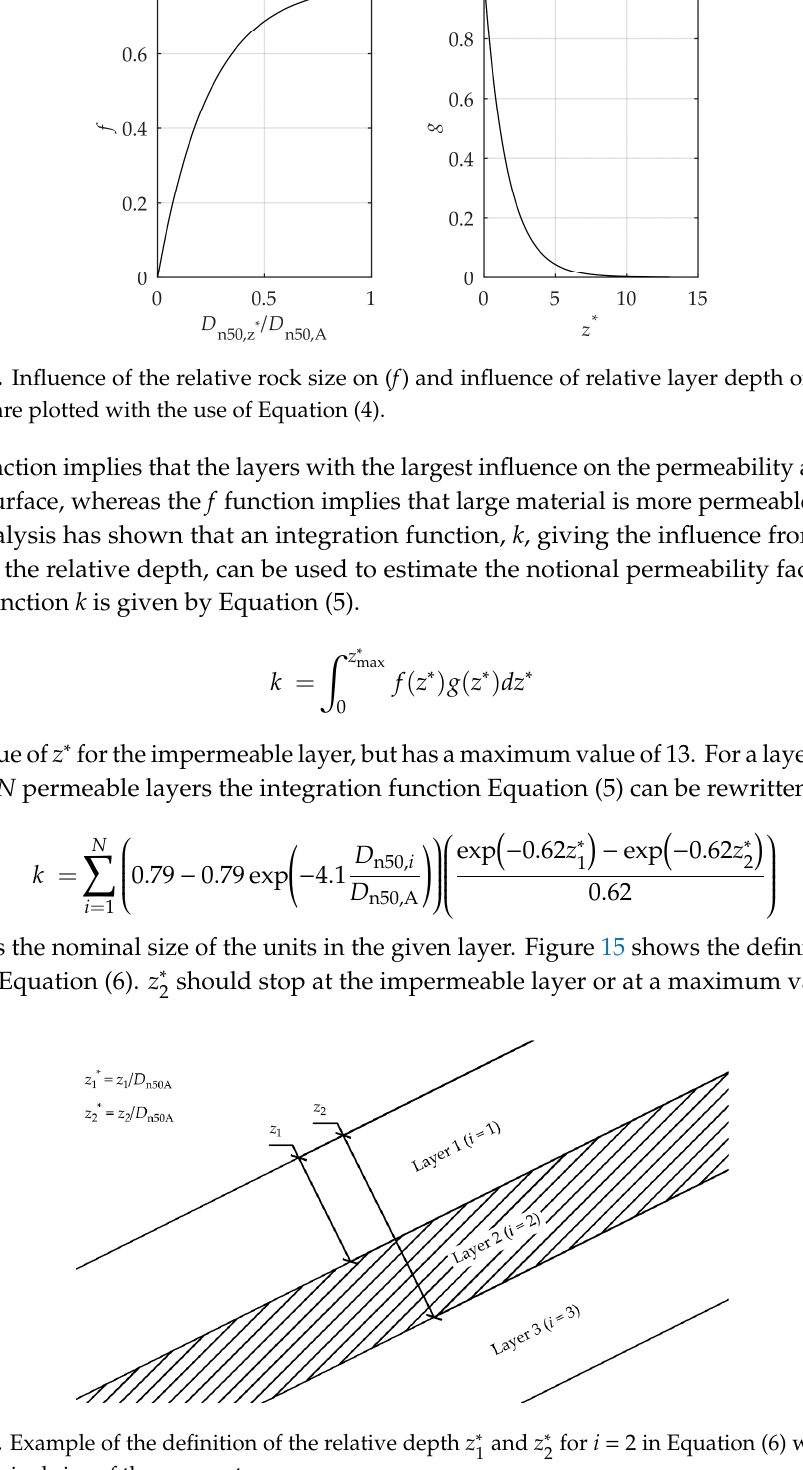
and z ∗ for i = 2 in Equation (6) with D n50A 2 1